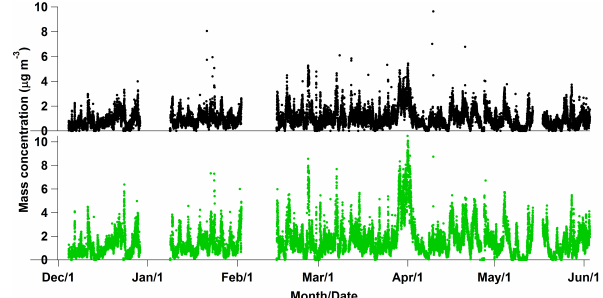
Figure 2. Extracted mass spectra from two-factorial PMF analysis: (top) mass spectra identified as HOA; (bottom) mass spectra identi- fied as LV-OOA.